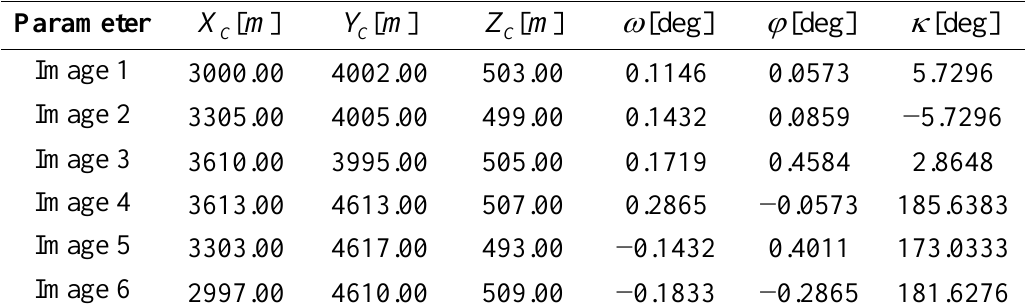
Table 2. EOPs of six bundle block images for